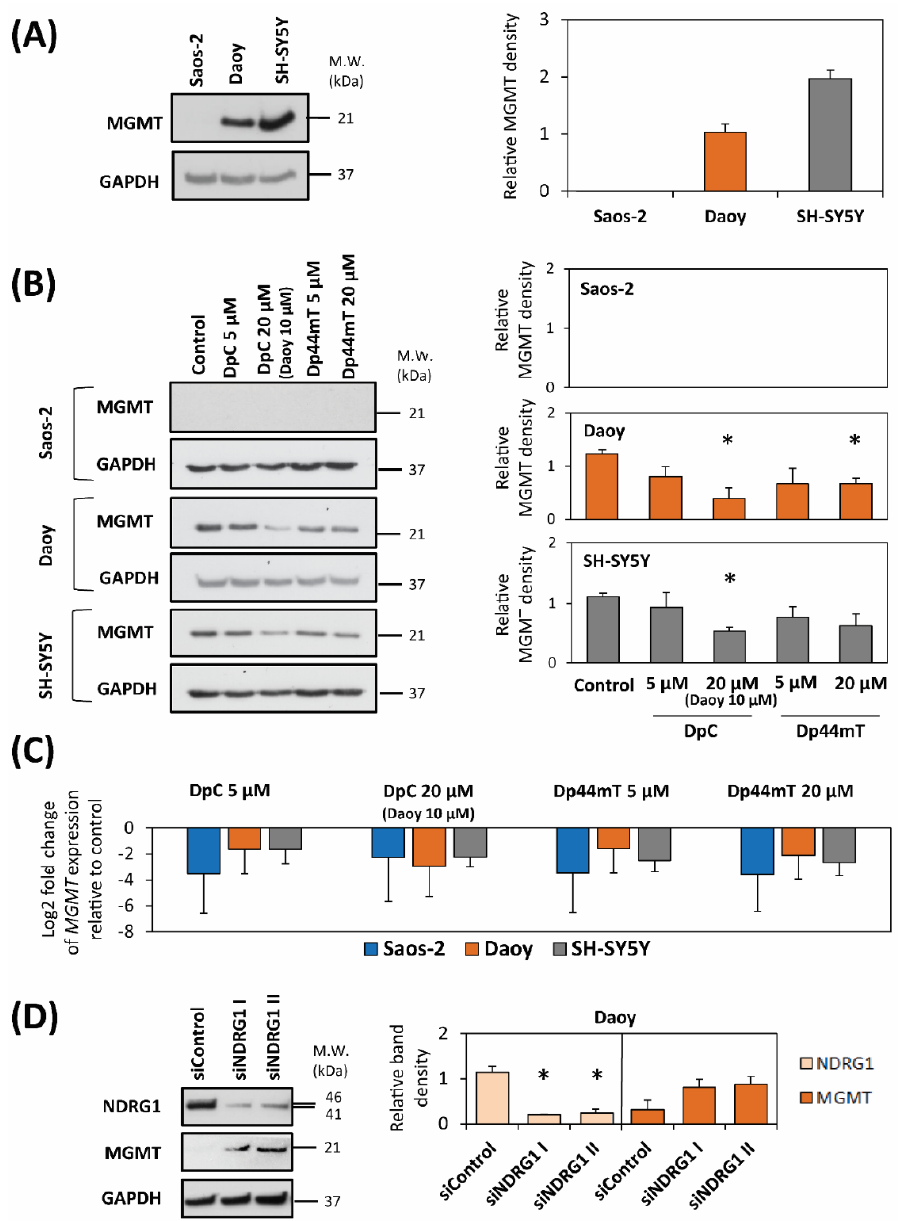
Figure 4. MGMT mRNA and protein expression was markedly down ‐ regulated in cells after incubation with either control medium, DpC (20 μ M; 10 μ M for Daoy), or Dp44mT (20 μ M) for 24 h/37 °C. ( A ) Western blot analysis of the endogenous MGMT level in untreated control cells. GAPDH served as a loading control. ( B ) Western blot analysis of the MGMT level in Saos ‐ 2, Daoy and SH ‐ SY5Y cells after a 24 h/37 °C of incubation with DpC or Dp44mT. GAPDH served as a loading control. ( C ) The graph shows changes in mRNA expression of MGMT in Saos ‐ 2, Daoy and SH ‐ SY5Y cells after 24 h of incubation with DpC or Dp44mT. These data were obtained by RT ‐ qPCR. The levels of gene expression after thiosemicarbazone treatment are presented as the log 2 fold change in mRNA expression relative to the untreated control. GAPDH served as a reference control. ( D ) Western blot analysis of NDRG1 and MGMT levels after NDRG1 silencing. Two specific siRNAs for NDRG1 were transiently transfected into Daoy cells with subsequent 48 h incubation. The cells were then transfected with a non ‐ targeting, negative control siRNA as a relevant control. GAPDH served as a protein loading control. The western blots presented are from a typical experiment of three performed, while the quantitation of the blots is presented as mean ± SD (three experiments). These data were analyzed by the unpaired Welch’s t ‐ test followed by the Games ‐ Howell post hoc test. * ( p < 0.05) indicates significant differences compared to the respective control group.